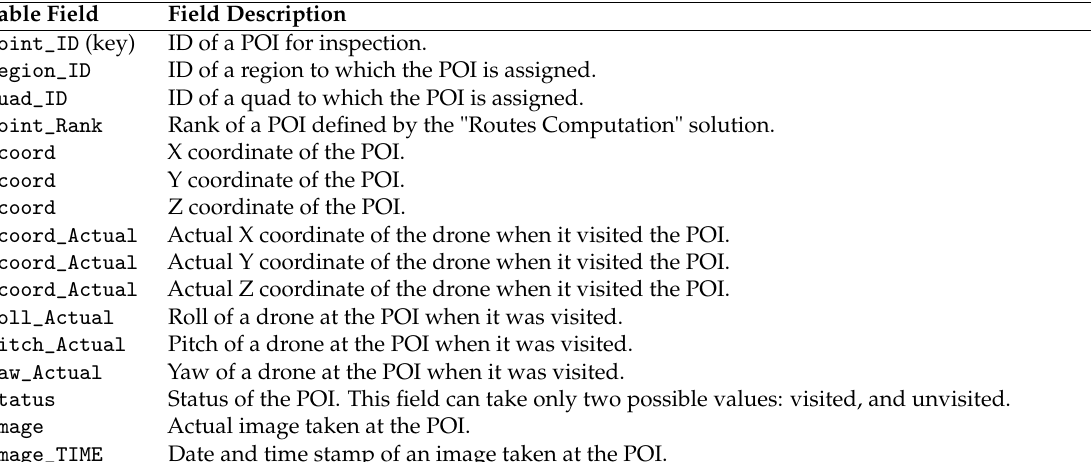
Table 3. Definition of the table “Points”. Field